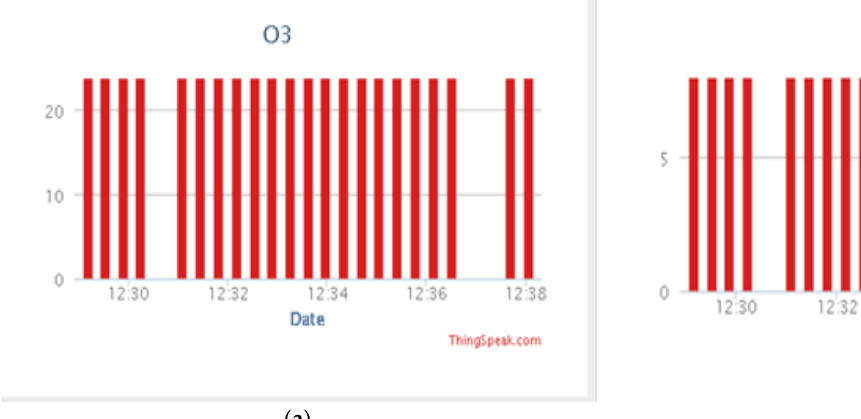
Figure 15. ( a ) O 3 level, ( b ) NO 2 level.